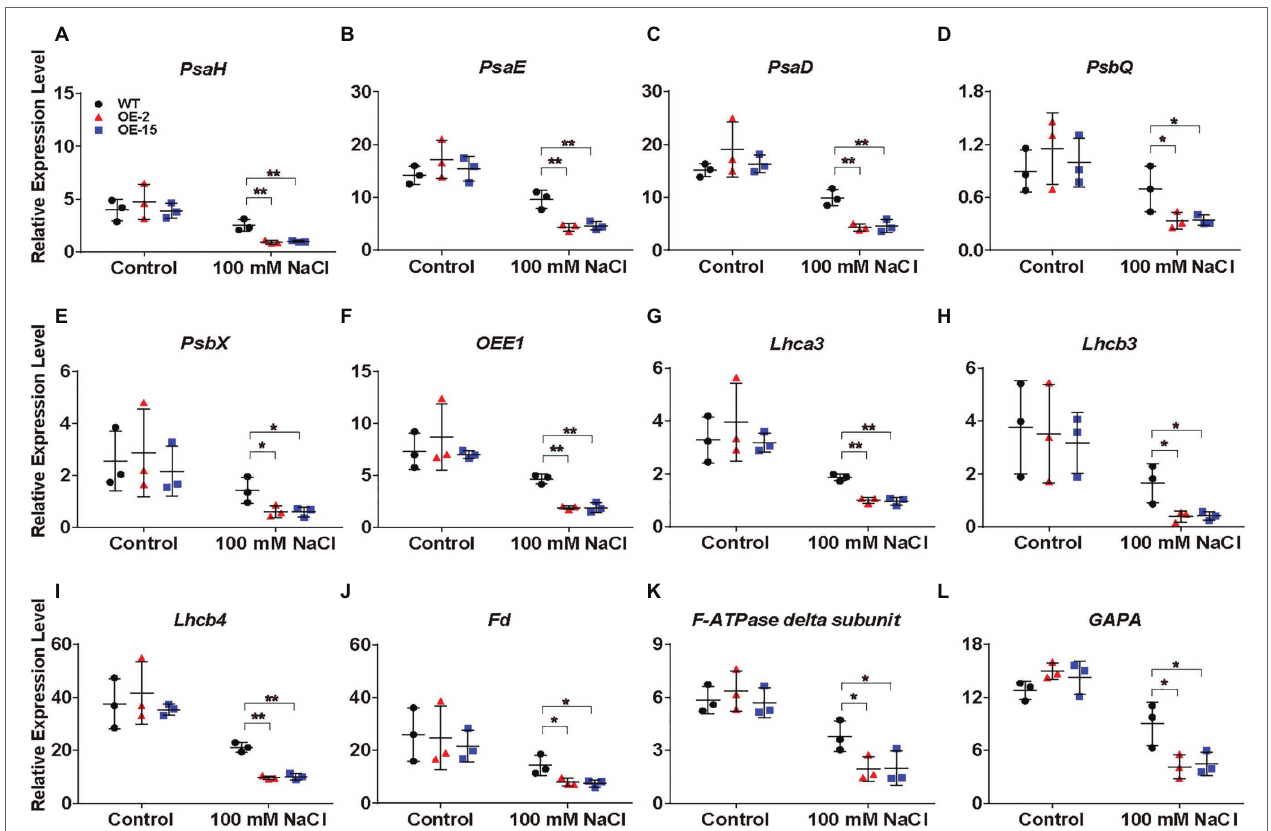
FIGURE 10 | Relative expression analysis of photosynthesis-related genes determined by RT-qPCR in tobacco leaves. (A-L) The expression of these genes is relative to the reference gene L25 under control conditions and salt stress (100 mM NaCl) at 4 DAT. Their gene IDs in the reference tobacco genome database (ftp://ftp.solgenomics.net/genomes/Nicotiana_tabacum/edwards_et_al_2017/assembly/Nitab-v4.5_genome_Chr_Edwards2017.fasta.gz) are PsaH (Nitab4.5_0000351g0060), PsaE (Nitab4.5_0000385g0230), PsaD (Nitab4.5_0014875g0010), PsbQ (Nitab4.5_0002345g0070), PsbX (Nitab4.5_0000073g0060), OXYGEN EVOLVING ENHANCER PROTEIN 1 ( OEE1 ; Nitab4.5_0000108g0110), LIGHT-HARVESTING CHLOROPHYLL PROTEIN COMPLEX ( Lhca3 ; Nitab4.5_0000923g0200), Lhcb3 (Nitab4.5_0012832g0010), Lhcb4 (Nitab4.5_0011597g0020), Fd (Nitab4.5_0004129g0010), F-ATPase delta subunit (Nitab4.5_0006745g0030), and GLYCERALDEHYDE-3-PHOSPHATE DEHYDROGENASE A ( GAPA ; Nitab4.5_0010299g0040). Error bars indicate ±SD ( n = 3). One- way ANOVA with LSD test (* p < 0.05 and ** p < 0.01) was used to analyze statistical